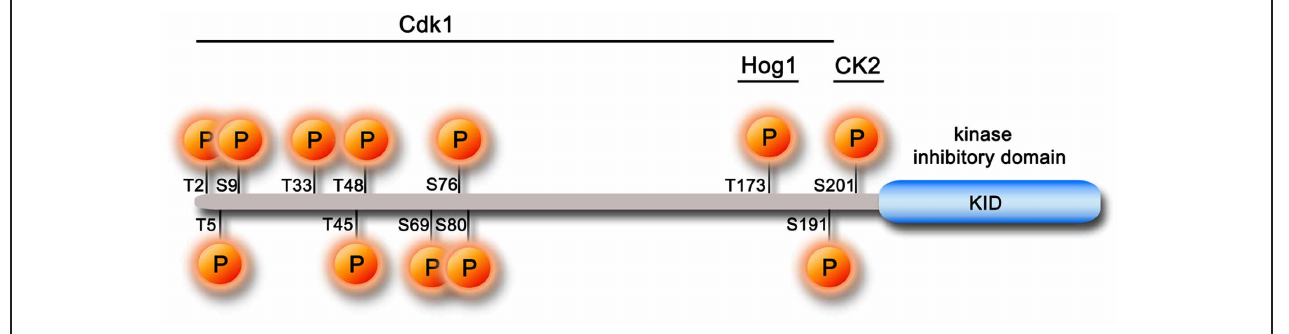
indicated as a blue box. The main kinases that regulate Sic1 activity in the cell cycle are indicated, along with their phosphorylation sites on the whole